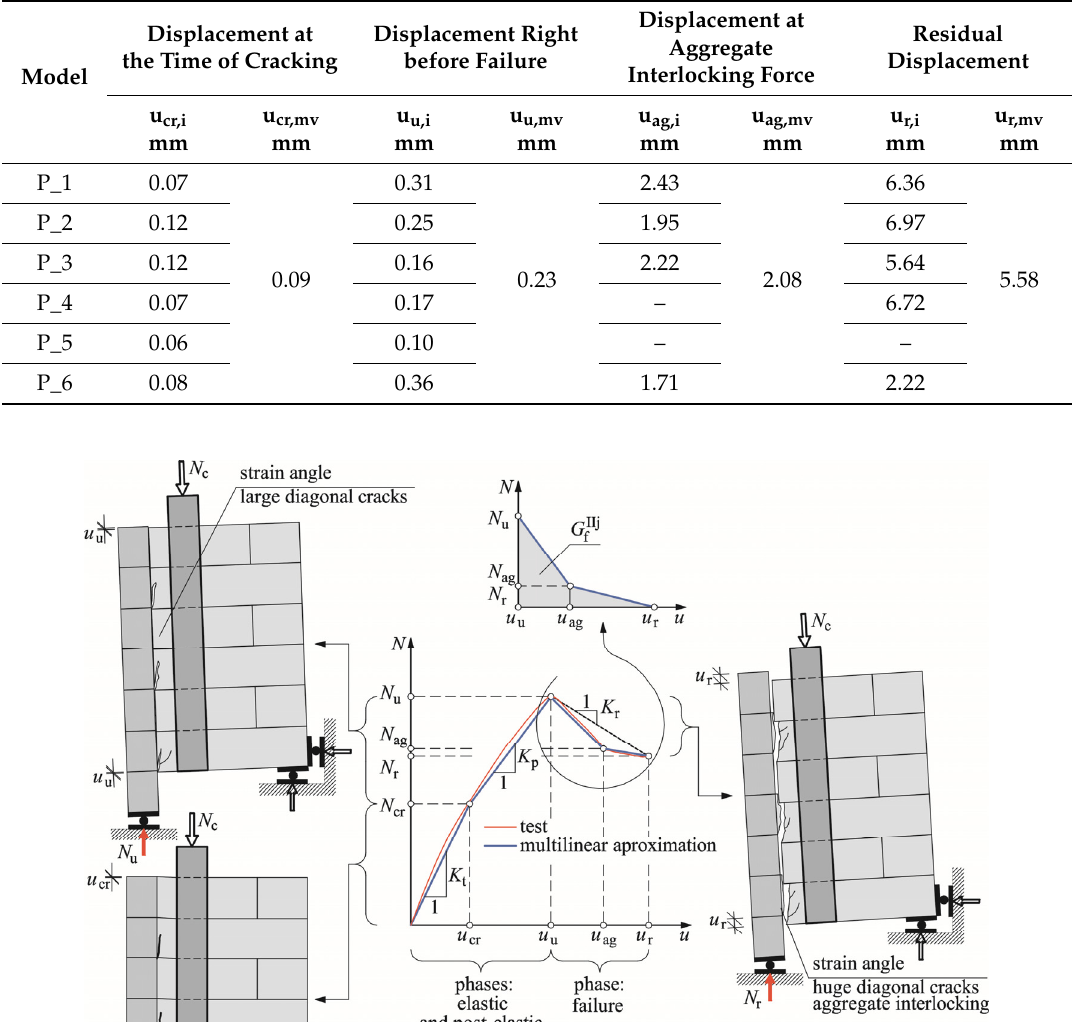
Table 3. Test results for joints between unreinforced walls (displacements).